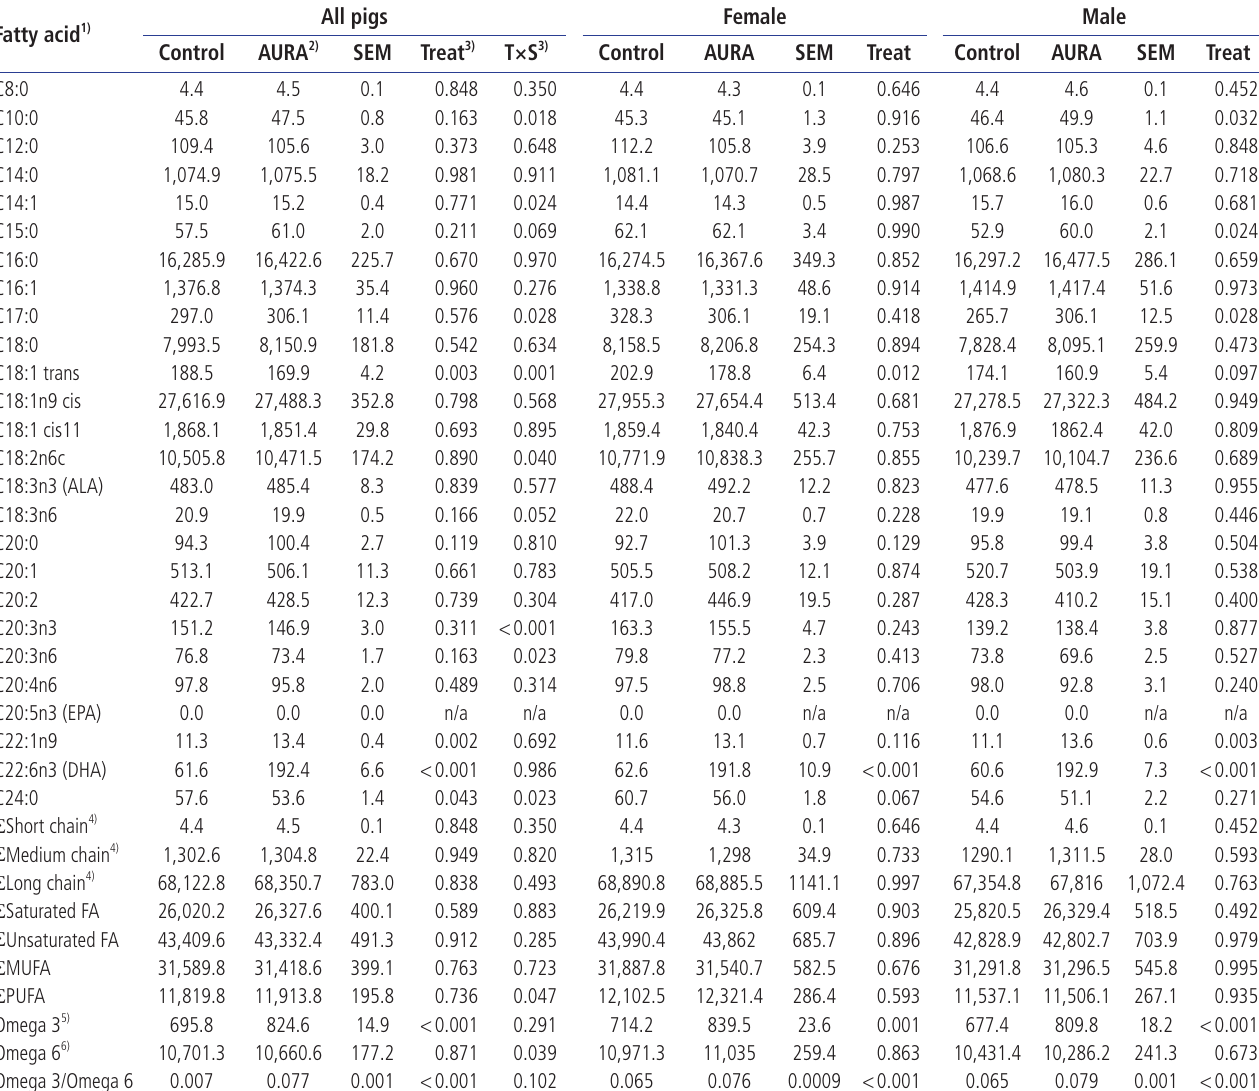
Table 6. Pork backfat fatty acid profile (mg/100 g tissue) for control and AURA supplemented pigs All pigs Female Fatty acid 1)